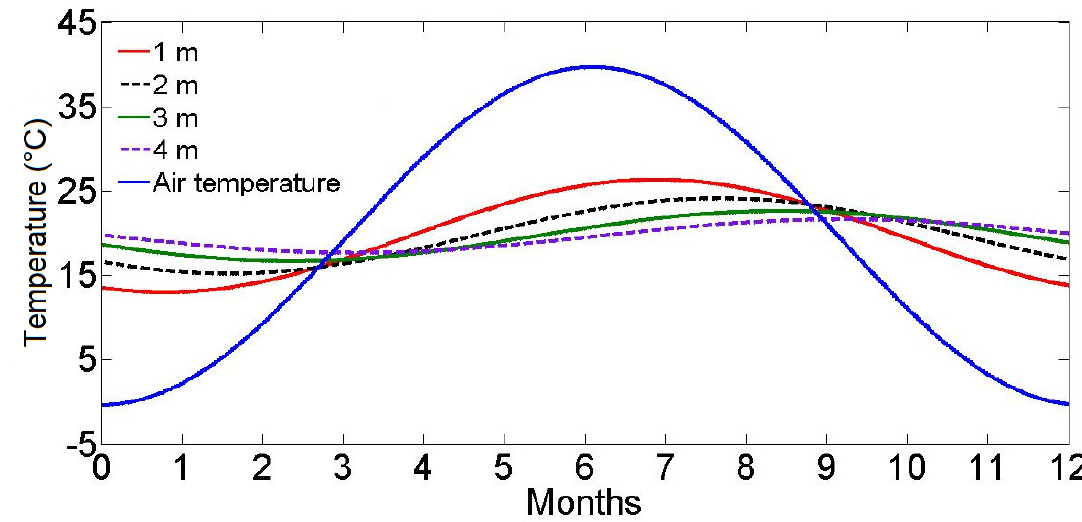
Figure 2. Annual variation in temperatures of ambient air and soil at different depths for Las Vegas.